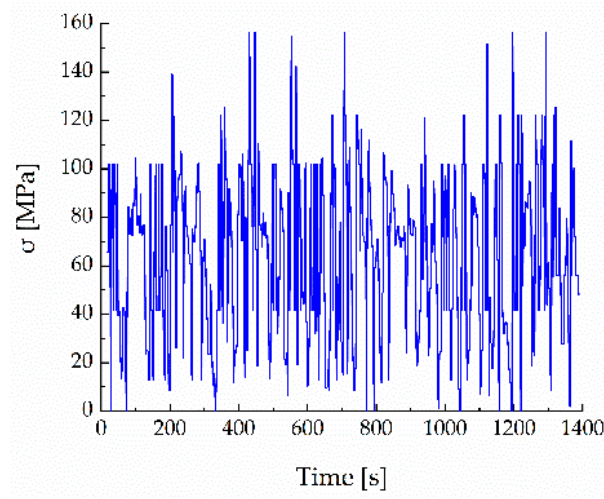
Figure 13. Load spectrum of friction braking bending stress.